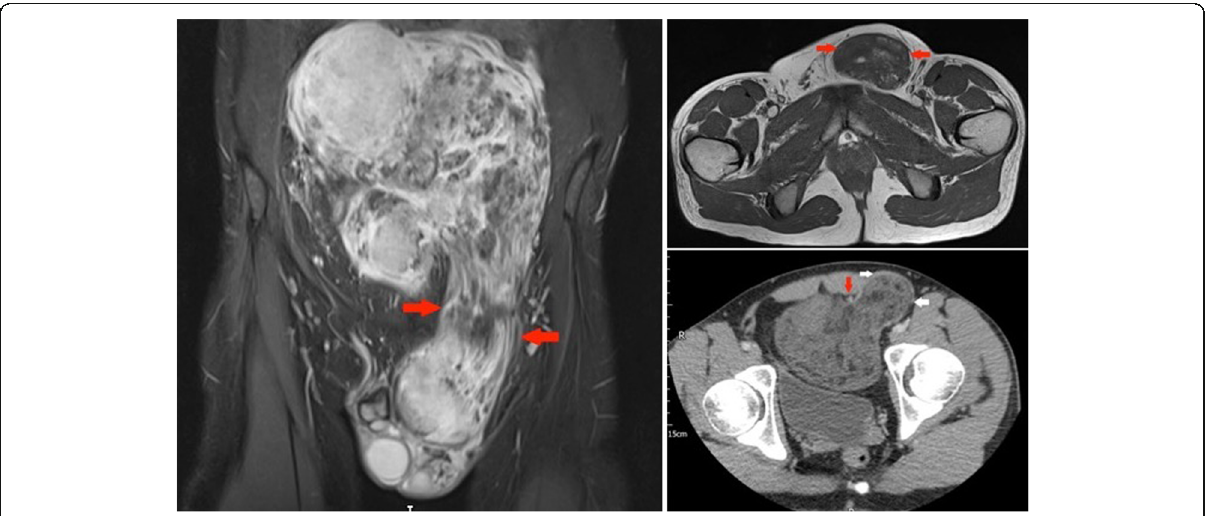
Fig. 3 Left panel: Coronal T1 TIRM-weighted MR image of the abdomen and pelvis: large intra-abdominal mass with areas of fat suppression suggesting a fat containing tumour. The tumour is seen to herniate through the left inguinal canal (red arrows). Right upper panel: Axial T1- weighted MR image of the pelvis: A large left indirect inguinal hernia is observed (red arrows). On T1-weighted imaging fat content is identified which would suggest liposarcoma. Right lower panel: Axial contrast-enhanced CT of the abdomen and pelvis: a large intra-pelvic lesion is observed herniating through a groin defect (white arrows) lateral to the inferior epigastric vessels (red arrow). It appears to be displacing and compressing the bladder